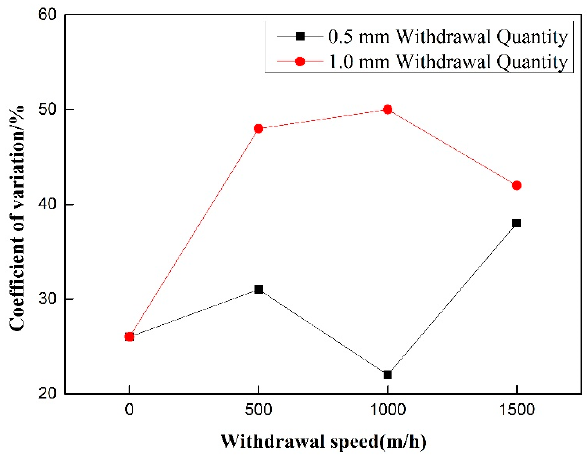
Figure 13. Effect of withdrawal speed on coefficient of variation under different withdrawal quantity. Figure 13. E ff ect of withdrawal speed on coe ffi cient of variation under di ff erent withdrawal quantity.